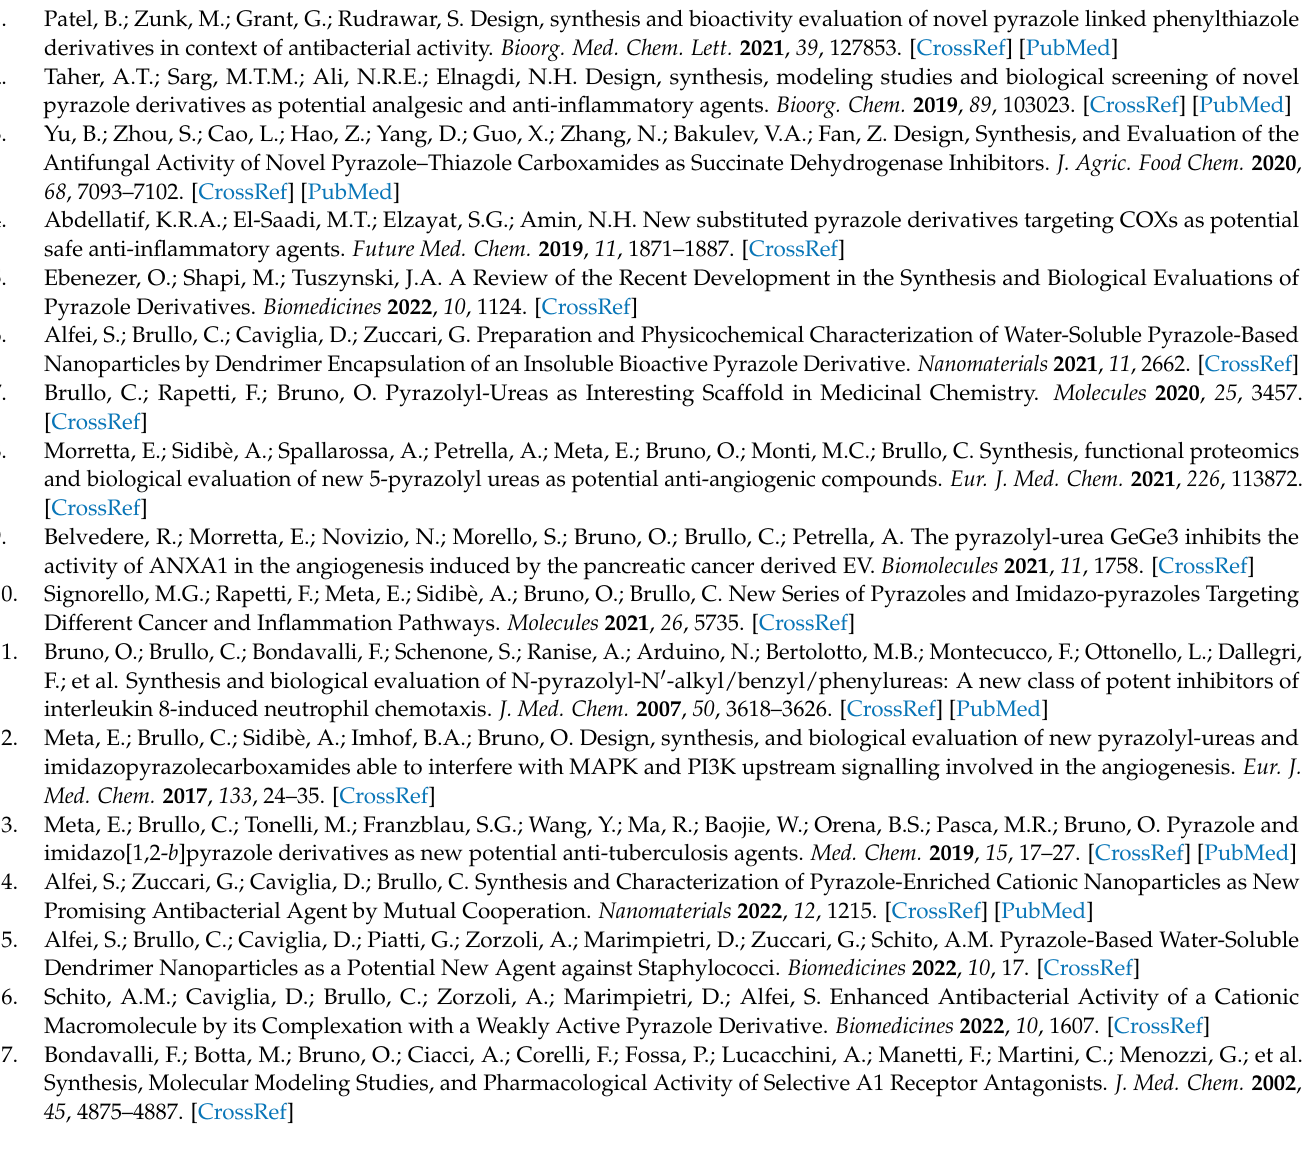
IR of 5c. Figure S7. 1 H NMR of 5d. Figure S8. 13 C NMR of 5d. Figure S9. IR of 5d. Figure S10. 1 H NMR of 6. Figure S11. 13 C NMR of 6. Figure S12. IR of 6. Figure S13. 1 H NMR of 7. Figure S14. 13 C NMR of 7. Figure S15. IR of 7